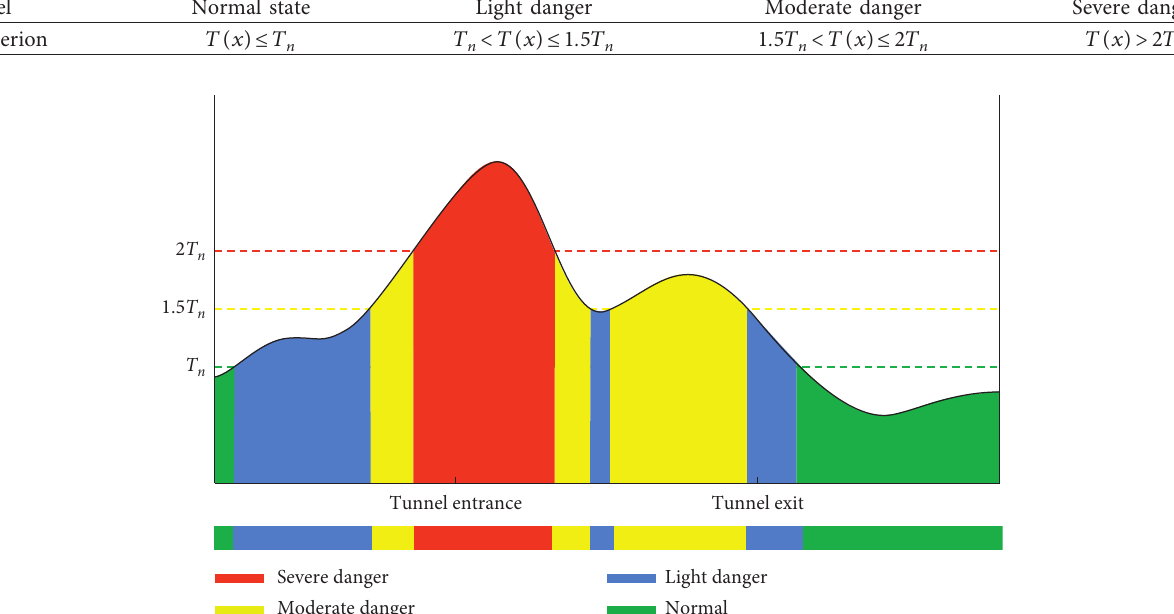
Figure 7: The results of tunnel environment risk level